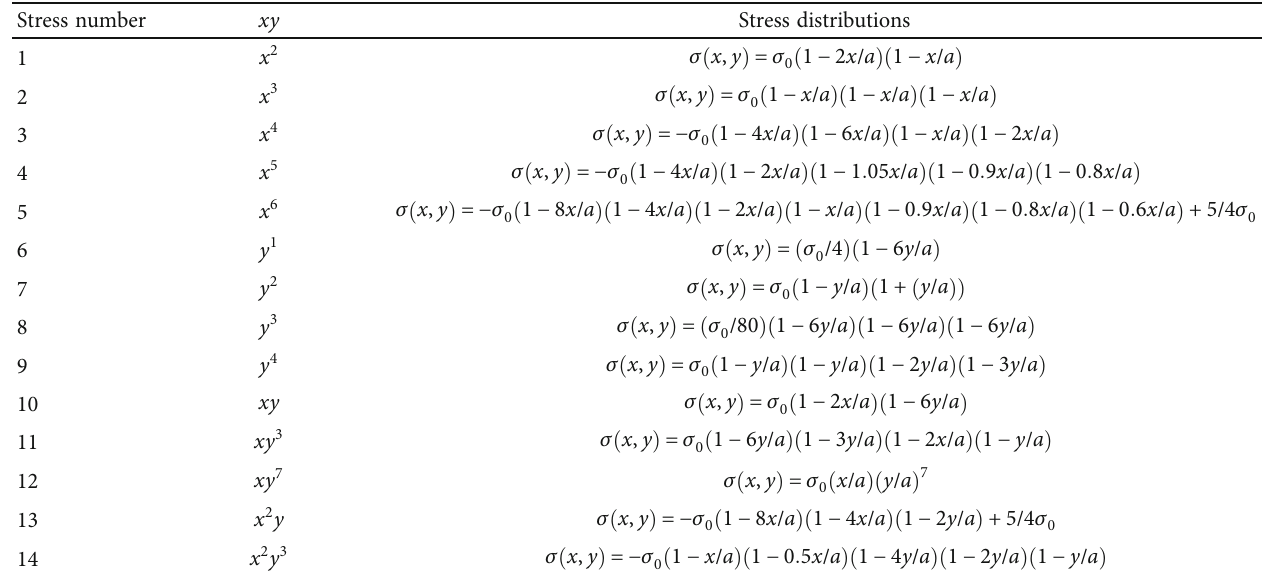
Table 1: Stress distributions applied onto the crack